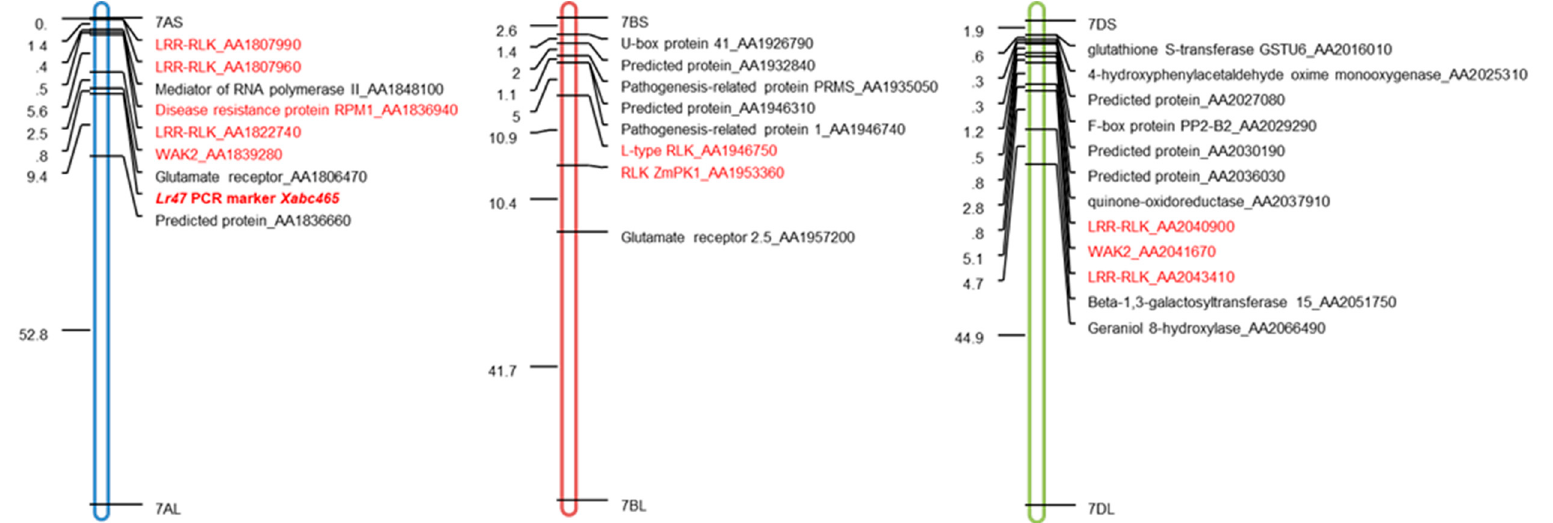
Figure 3. Distribution map of transcriptional-induced genes located on chromosomes 7AS, 7BS, and 7DS. The race-specific resistance gene Lr47 was introgressed from chromosome 7S of Aegilops speltoides to chromosome 7AS of hexaploid wheat Triticum aestivum . Previous genetic study identified a PCR marker Xabc465 that co-segregated with the Lr47 gene. A total number of 28 upregulated genes located on chromosomes 7AS, 7BS, and 7DS were identified from the assembled transcriptome, and ten of which encoded RLKs (labeled in red color, detailed information in Table 2). The physical position for each of the gene was determined and anchored to the distribution map using MapMaker software.